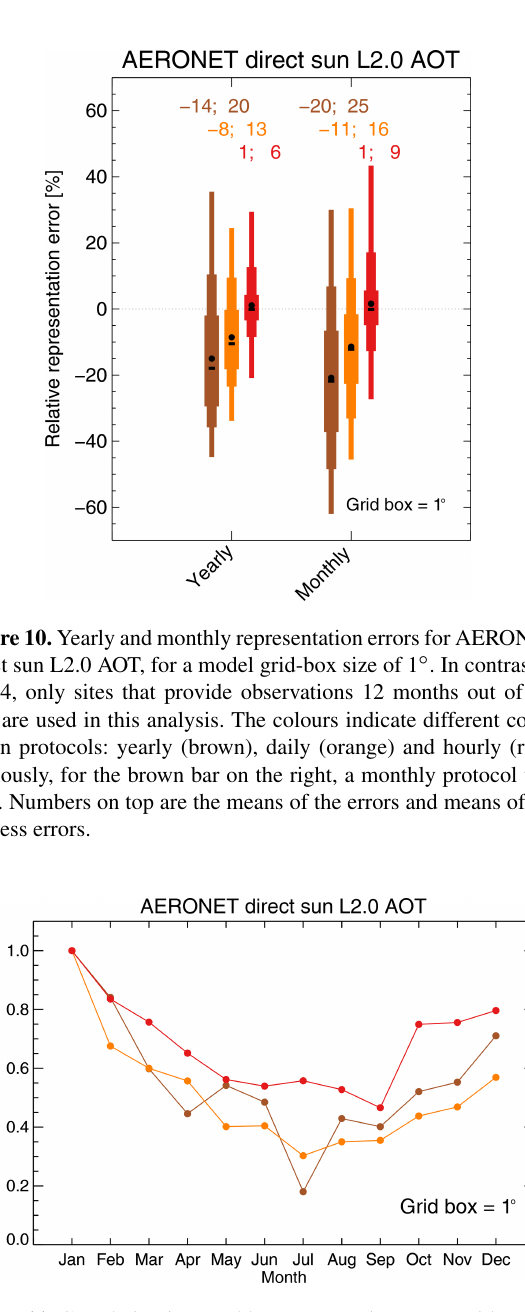
Figure 11. Correlation in monthly representation errors with errors for January, for AERONET direct sun L2.0 AOT, for a model grid- box size of 1 ◦ . Only sites that provide observations 12 months out of the year are used in this analysis. The colours indicate different collocation protocols: monthly (brown), daily (orange) and hourly (red).